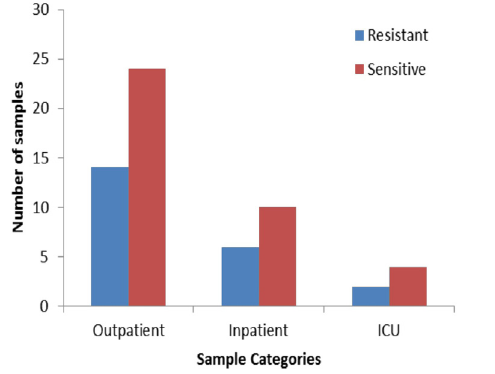
Fig. 2. Distribution of antibiotic resistance pattern of Escherichia coli isolated from patients